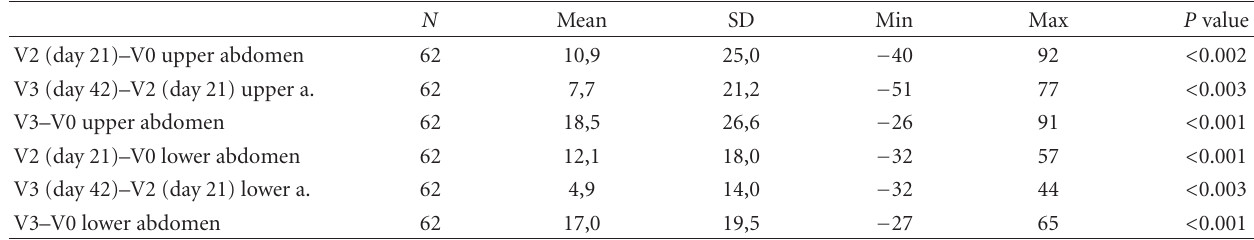
Table 1: Changes of symptom scores for upper abdomen, and lower abdomen (mean, standard deviation, minimum, maximum, P value 2sided Wilcoxon-test).